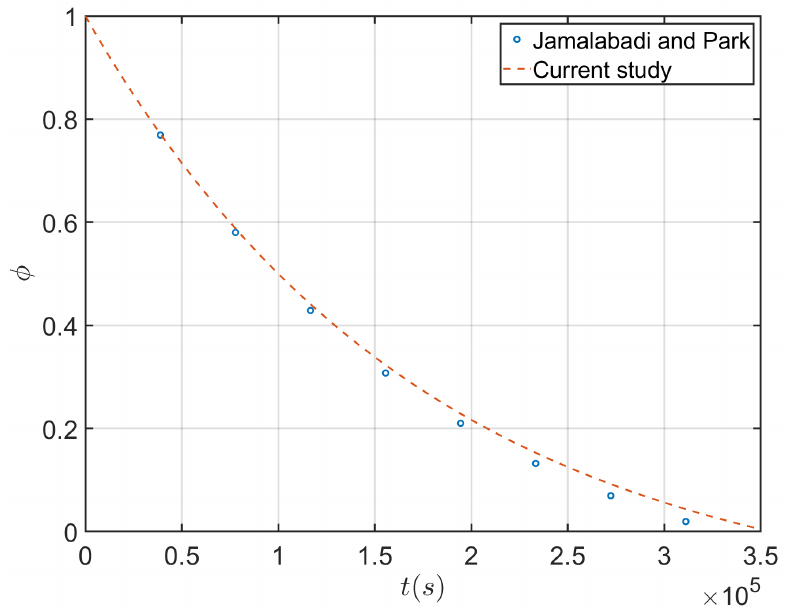
Figure 6. Comparison of the results of current method with Jamaabadi and Park